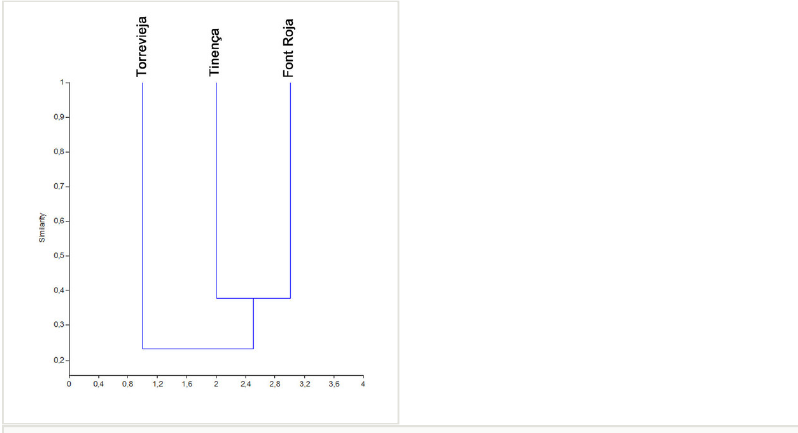
Cluster of Jaccard analysis reflecting relationship between Natural Parks.